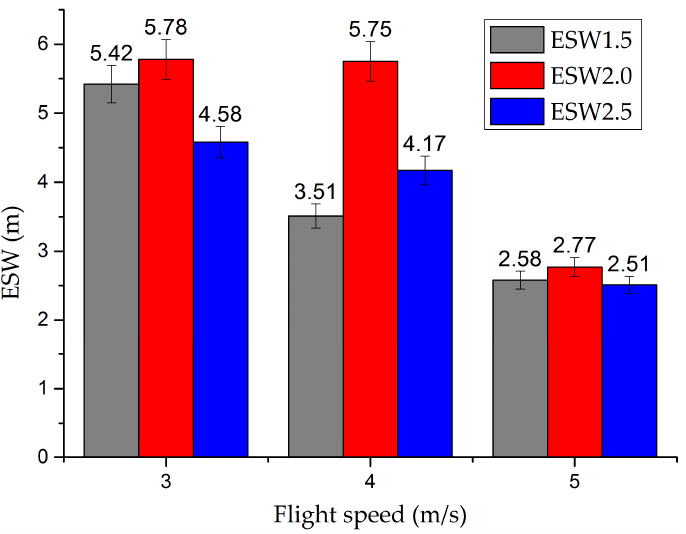
Figure 4. Effective spraying width (ESW) changes under different speeds. Note: ESW1.5, ESW2.0, ESW2.5 represent the ESW when the flight height (FH) was 1.5, 2.0, and 2.5 m, respectively. The two-way ANOVA was conducted to verify the significance effect of FS and FH on ESW at the p -value = 0.05 level, and the results are shown in Table 6. The FS has a highly significant impact on ESW ( p = 0.0033 < 0.01), the FH has no significant impact on the ESW ( p = 0.136 > 0.05), and the interaction between FS and FH also has no significant impact on ESW ( p = 0.906 >